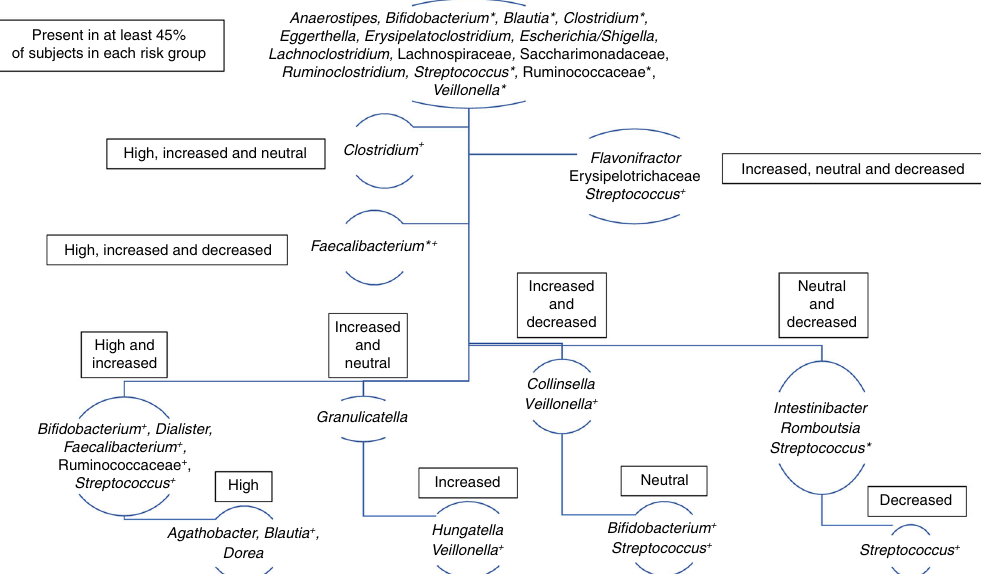
Fig. 4 Highly prevalent ASVs are either shared or unique to HLA groups. Hierarchy organization map displaying those taxa that are present in at least 45% of subjects in one or more risk groups. Taxa indicated with an asterisk (*) are represented by more than one ASV which are considered unique. Furthermore, those taxa indicated with a cross ( + ) represent bacteria shared at the taxonomic level but are actually unique to one or a combination of groups at the ASV level